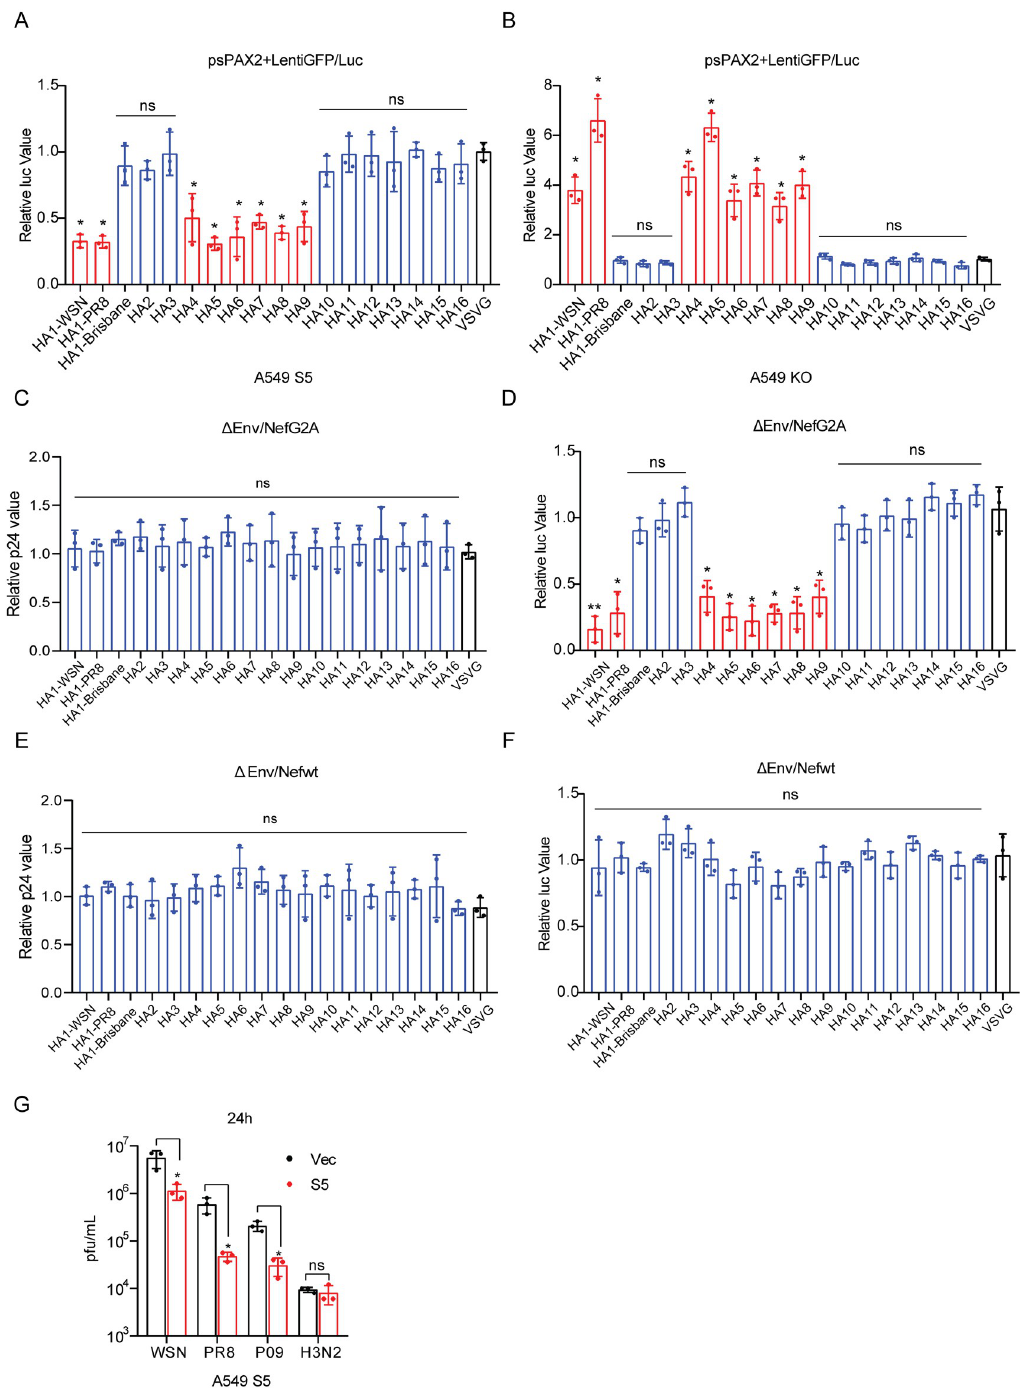
Fig 4. SERINC5inhibits multiple IAV strains. A-B: Pseudoviruses were produced by transfecting HEK293T cells with plasmid DNA psPAX2, LentiGFP/Luc, pCAGGS-HA (expressing H1 to H16), pCAGGS-NA(WSN), or VSV G. The pseudoviruses were then used to infect A549 cells that either overexpress SERINC5 (A) or have SERINC5knocked out (B). Luciferase activity was measured to report viral infection. C-F: Δ Env/NefG2A HIV-1 NL4-3 (C, D) or Δ Env/NefWT HIV-1 NL4-3 (E, F) was used to producepseudoviruses carrying IAV HA protein (HA1 to HA16) in the presence of SERINC5. Viral particle production (C, E) and viral infectivity (D, F) were measured,and the resultsof three independent experiments are shown. G: A549 cells with SERINC5overexpression were infected with A/WSN/33, A/PR/8, A/H1N1pdm09 or A/H3N2 (MOI = 0.05). Titers of IAV in the supernatants were determined by viral plaque assays. Statistical significance was analyzed by unpaired t -test.ns: not significant; � : P < 0.05; �� : P < 0.01.